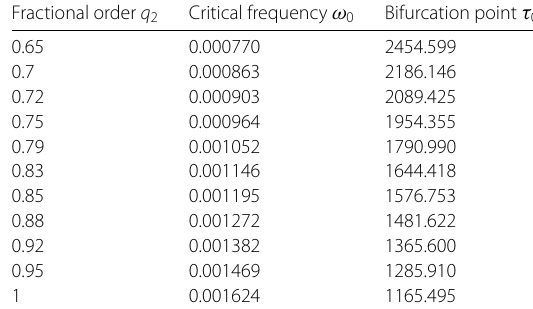
Table 3 The effect of q 2 on the values of ω 0 and τ 0 for system (29) when q 1 = 0.92